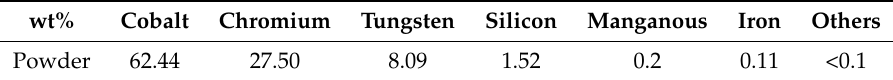
Table 1. Chemical composition of CoCrW powder.